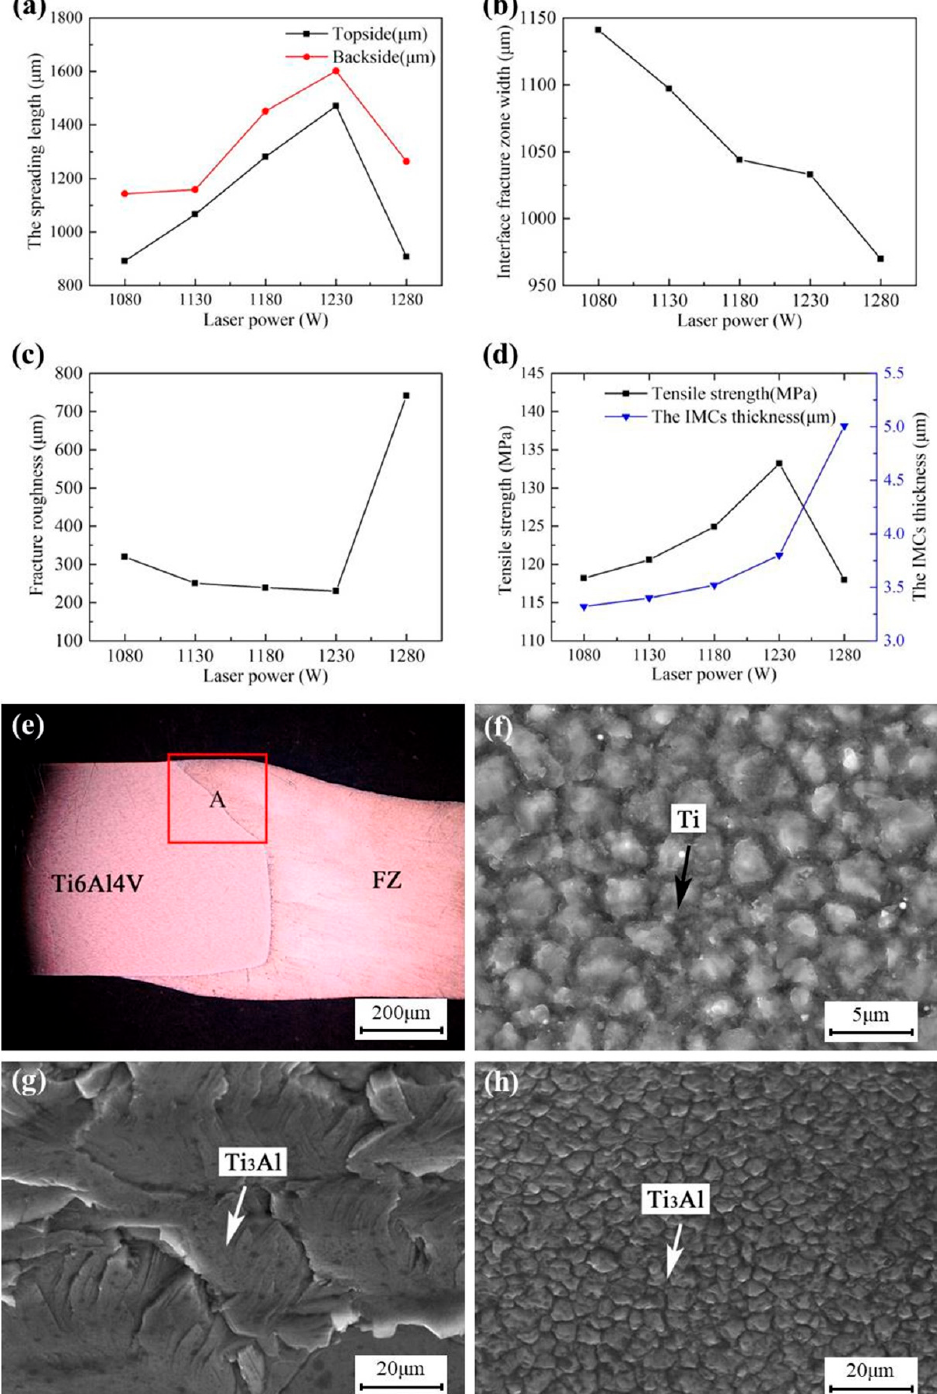
Figure 10. Influence of laser power on the joint properties: ( a ) the spreading length; ( b ) interface fracture zone width; ( c ) fracture roughness; ( d ) tensile strength and the IMC thickness, and cross section and details of the fracture of Joint #14: ( e ) cross section of the joint; ( f–h ) details of Areas Z8, Z9, and Z10 in Figure 4c, respectively.